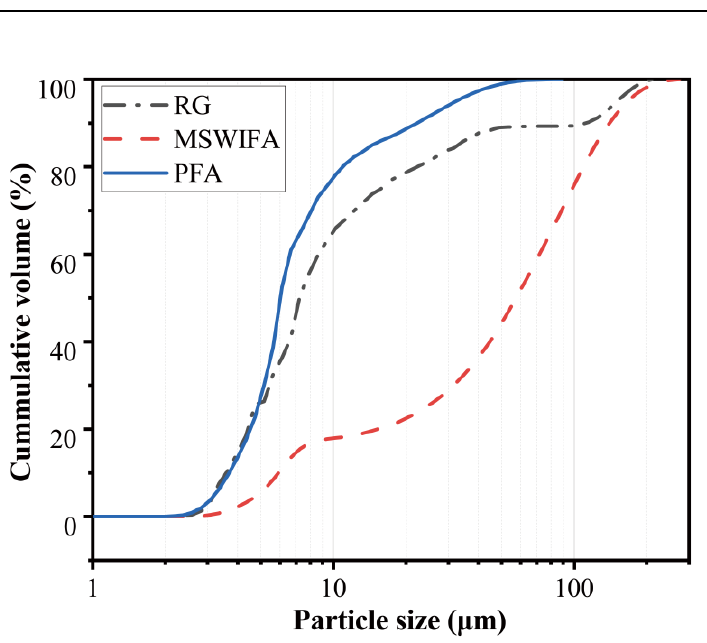
Figure 3. Raw material particle size. Table 1. The chemical compositions of raw materials.